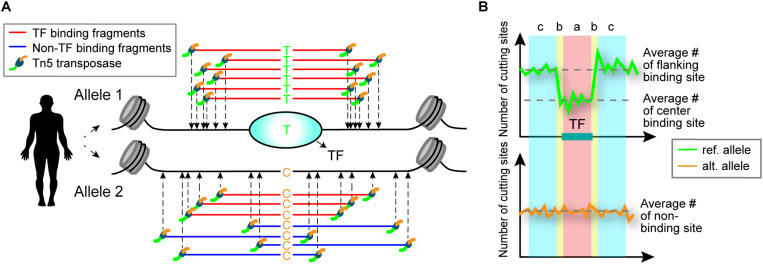
Schematic illustrating detection of allele-specific TF binding by ATAC-seq. (A) Schematic of allele-specific TF binding detected by ATAC-seq. Alleles 1 and 2 contain a single nucleotide difference in the TF-binding site, which results in preferential TF binding to allele 1. TF binding to the site prevents the Tn5 transposase from cleaving the DNA at that location. (B) The difference in TF binding is detected in ATAC-seq data by a characteristic footprint, observed as a dip in read counts at the binding site. An allele-specific binding (ASB) event is identified by the occurrence of this footprint in one allele (top) and uniform read counts in the other allele (bottom). The ASB regions are defined by transposase cut sites shown above the plot: a = TF-binding site, b = site shoulders, c = flanking region. The number of cut sites in region b are not considered in the regSNPs-ASB model to allow for variability in the size of the TF binding motifs.